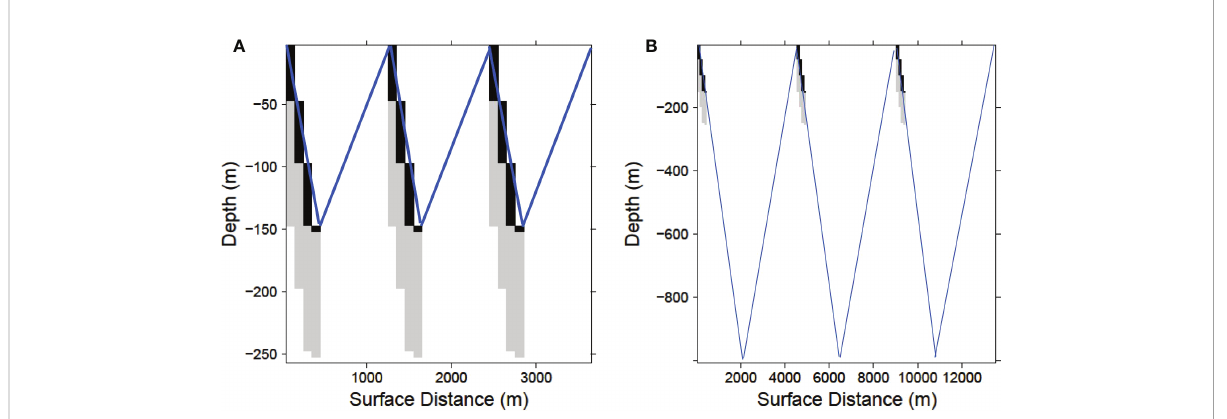
FIGURE 2 Schematic sample path (not to scale) of a glider completing 3 dives at with a maximum depth of (A) 150 m and (B) 1000 m. In each case the echosounder is shut off at 150 m, but the water column is ensoni fi ed 100 m below the glider to a maximum of 250 m as it descends. Black cells indicate when the echosounder is recording which together with the light gray cells represent the sampled area. Blue lines depict the completed glider descent-ascent